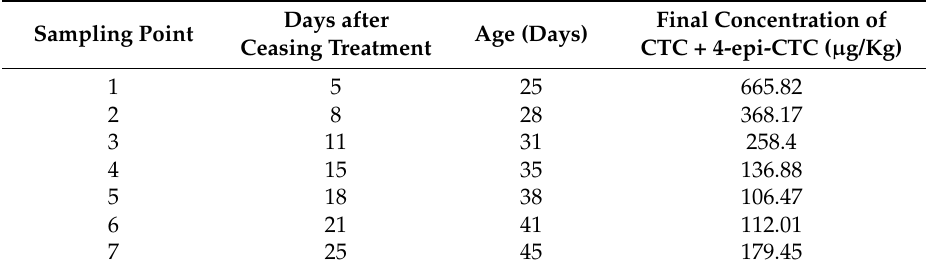
Table 3. CTC and 4-epi-CTC in droppings from broiler chickens treated with a commercial formulation, by sampling point.